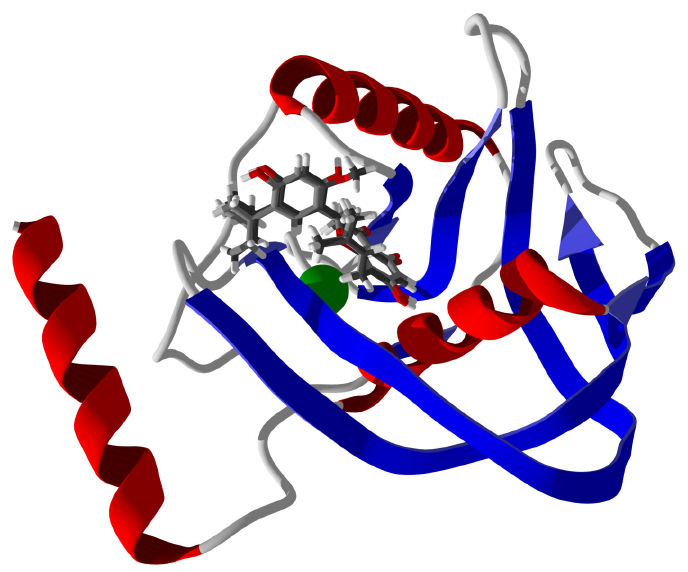
Figure 24. Lowest ‐ energy docked poses for 5 ′‐ (1,1 ‐ dimethyl ‐ 2 ‐ propenyl) ‐ 2 ′ ,4 ′ ,5,7 ‐ tetrahydroxy ‐ 8 ‐ prenylflavanone (220) (grey carbon skeleton) and 5 ′‐ (1,1 ‐ dimethyl ‐ 2 ‐ propenyl) ‐ 4 ′ ,5,7 ‐ trihydroxy ‐ 2 ′‐ methoxy ‐ 8 ‐ prenylflavanone (221) (black carbon skeleton) with Escherichia coli peptide deformylase (EcPDF, PDB 2G2A). The Ni 2+ cofactor in the catalytic site is shown as a green sphere.